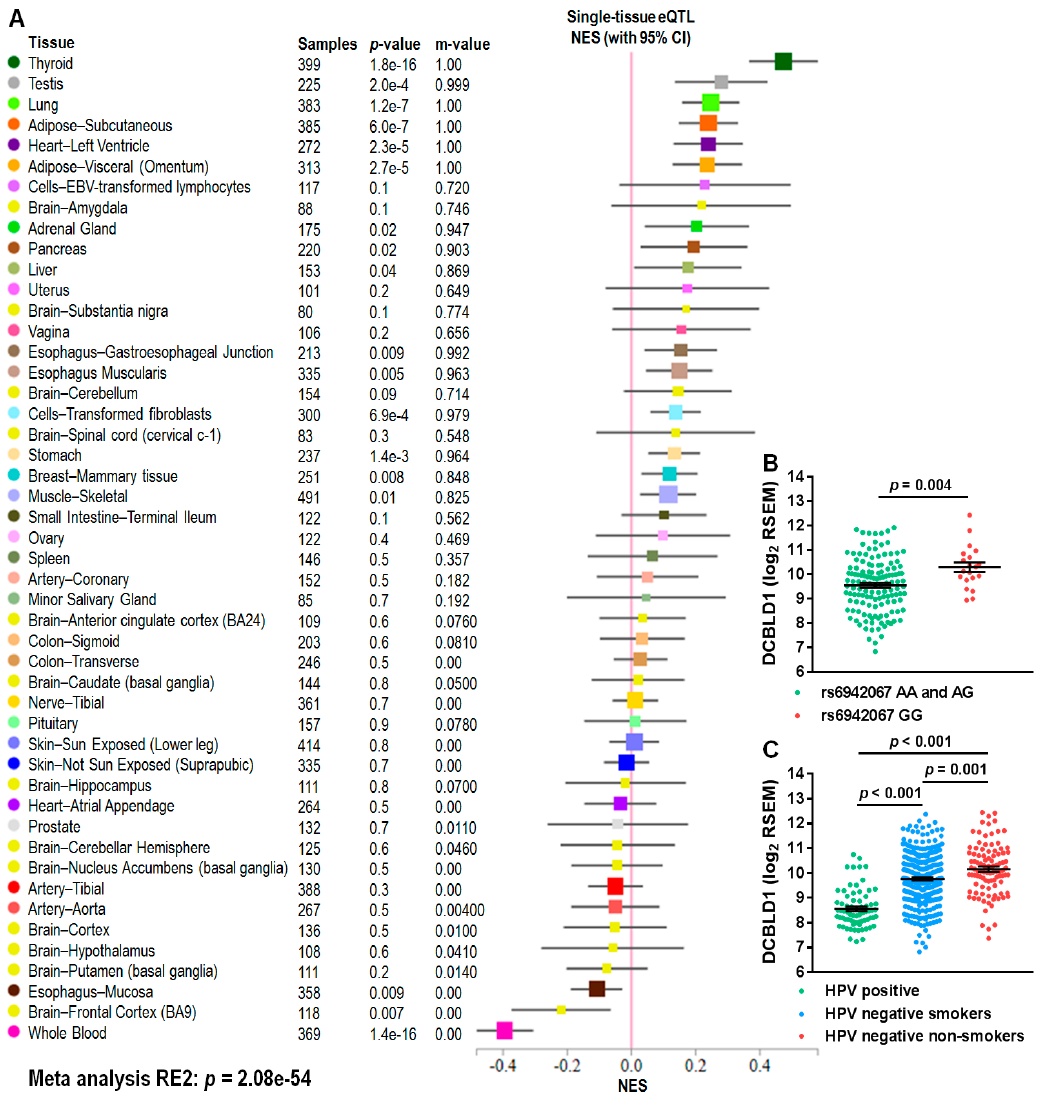
Figure 2. DCBLD1 gene expression, rs6942067, and HNSCC risk factors. ( A ) Multi-tissue